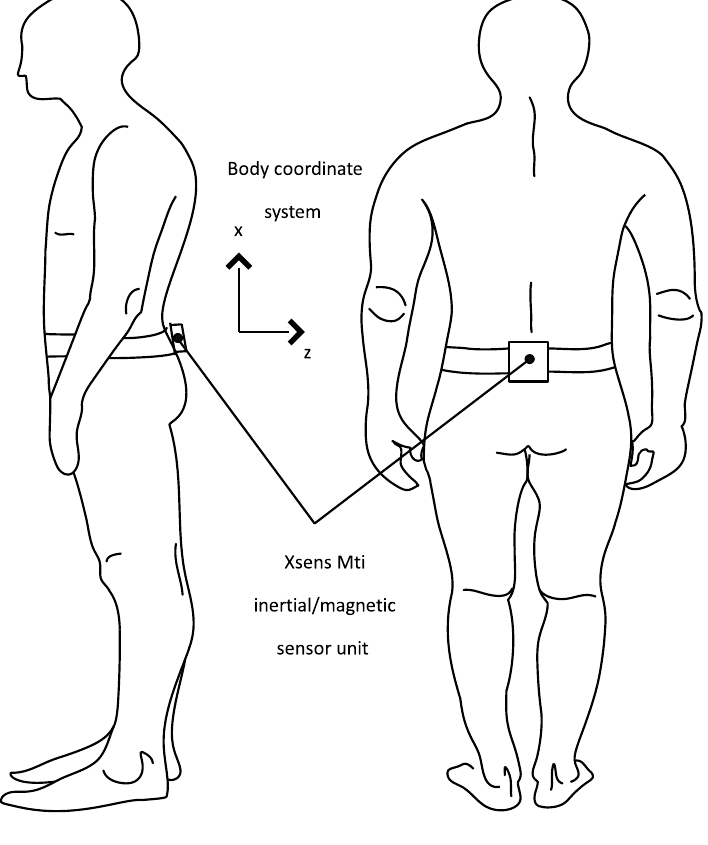
Figure 3. Inertial/magnetic sensor unit on the belt of a